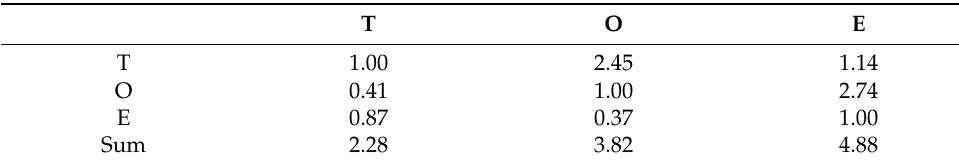
Table 1. Geometrical mean of pairwise comparison.